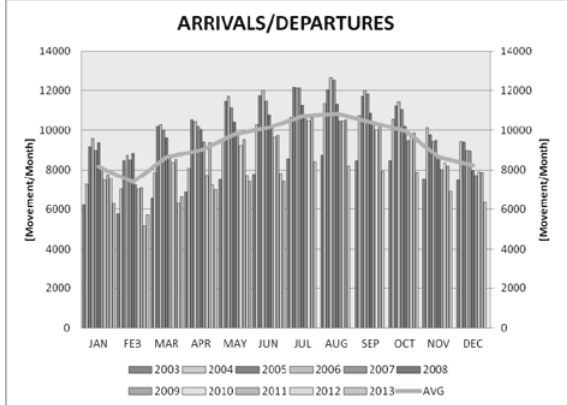
fig. 4. Arrivals and departures (Source: own edition based on Hungaro Control Data)